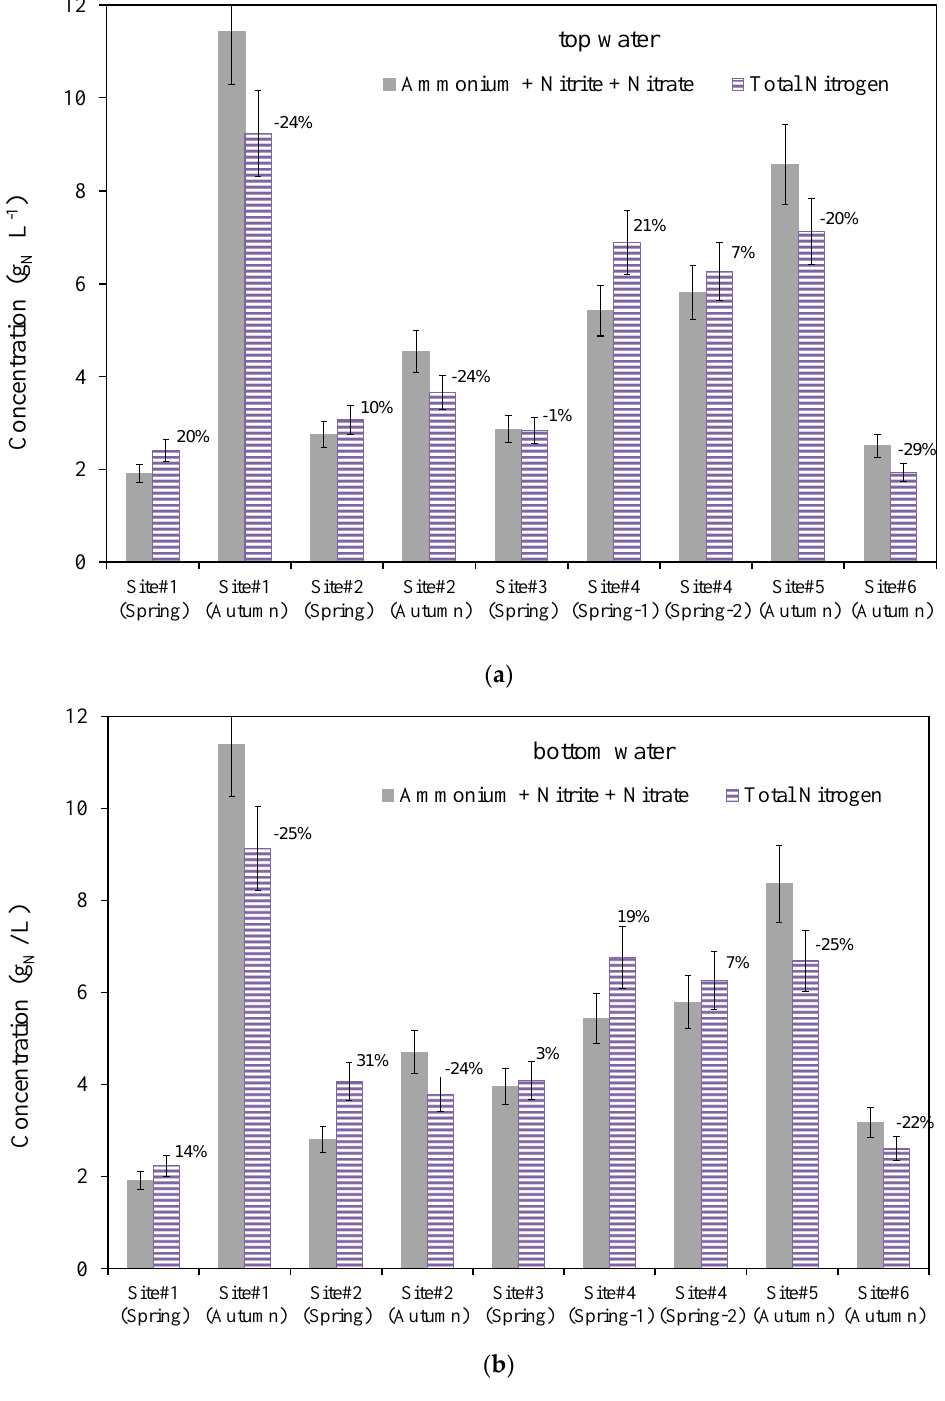
Figure 2. Total Nitrogen (TN) and Σ (NH 4+ + NO 2− + NO 3− ). The percentages indicated correspond to the relative difference between TN and Σ (NH 4+ + NO 2− + NO 3− ): ( a ) ‘top water’; ( b ) ‘bottom water’.